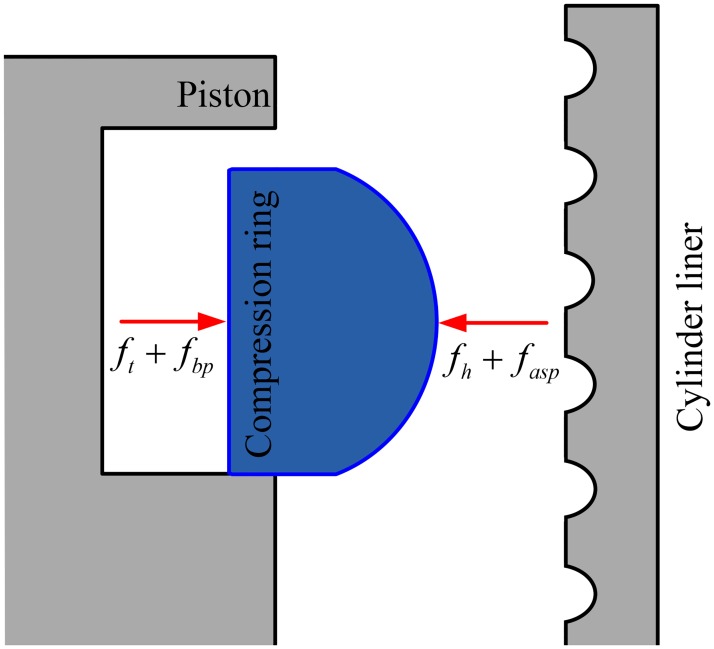
Radial forces acting on the compression ring.